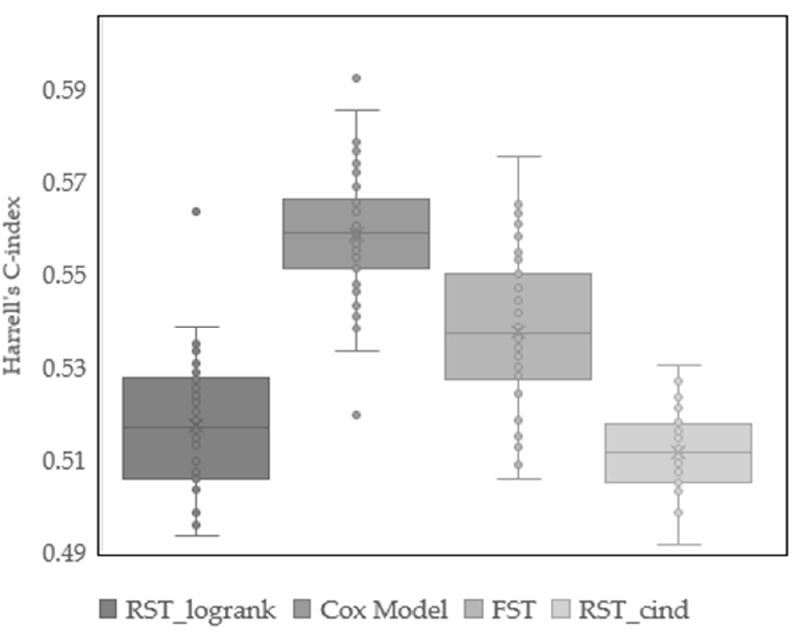
Figure 5. FST performance compared with other survival models using the original dataset (n_100).